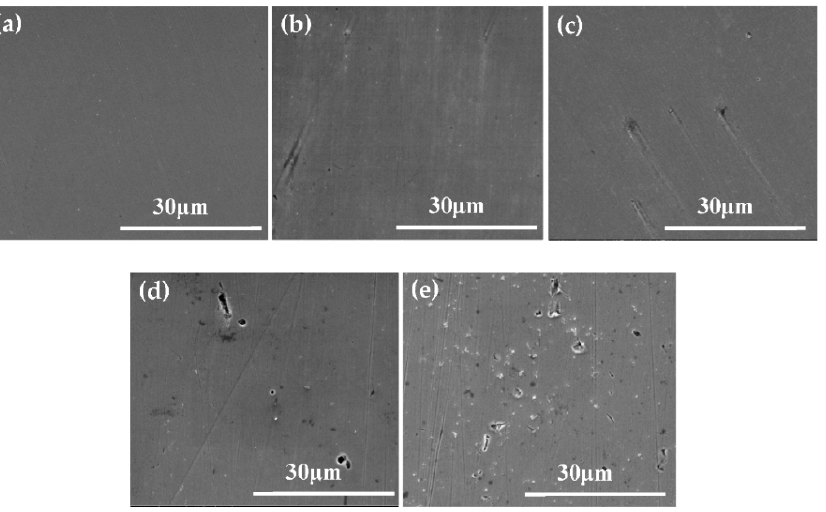
Figure 10. SEM-SE morphologies at 5000 × of the specimens surfaces at different exposure periods: Figure 10. SEM ‐ SE morphologies at 5000× of the specimens surfaces at different exposure periods: ( a ) 8 d, ( b ) 16 d, ( c ) 24 d, ( d ) 32 d and ( e ) 40 ( a ) 8 d, ( b ) 16 d, ( c ) 24 d, ( d ) 32 d and ( e ) 40 d.